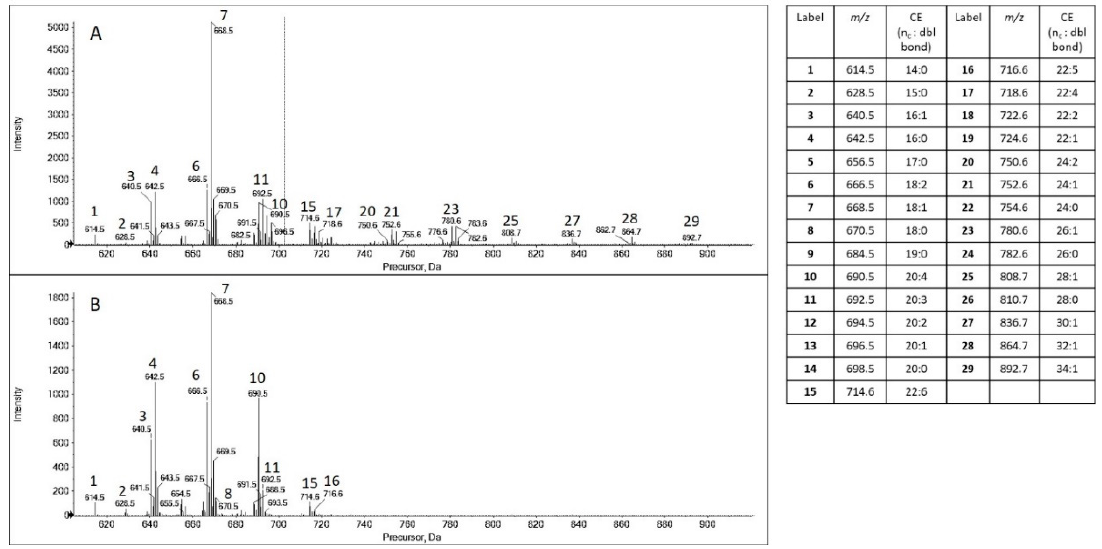
Figure 2. Representative pseudo precursor ion scanning mass spectra of cholesteryl esters (CEs, carbon number: double bond) extracted from MS / MS all data for ( A ) HMGECs and ( B ) culture media. Only those CEs present in all samples are included in the legend. Only the most abundant peaks are labeled in the figures to aid readability. CEs with carbon number ( n c < 24) are present in both HMGECs and culture media, while CEs with n c ≥ 24 are only present in HMGECs.